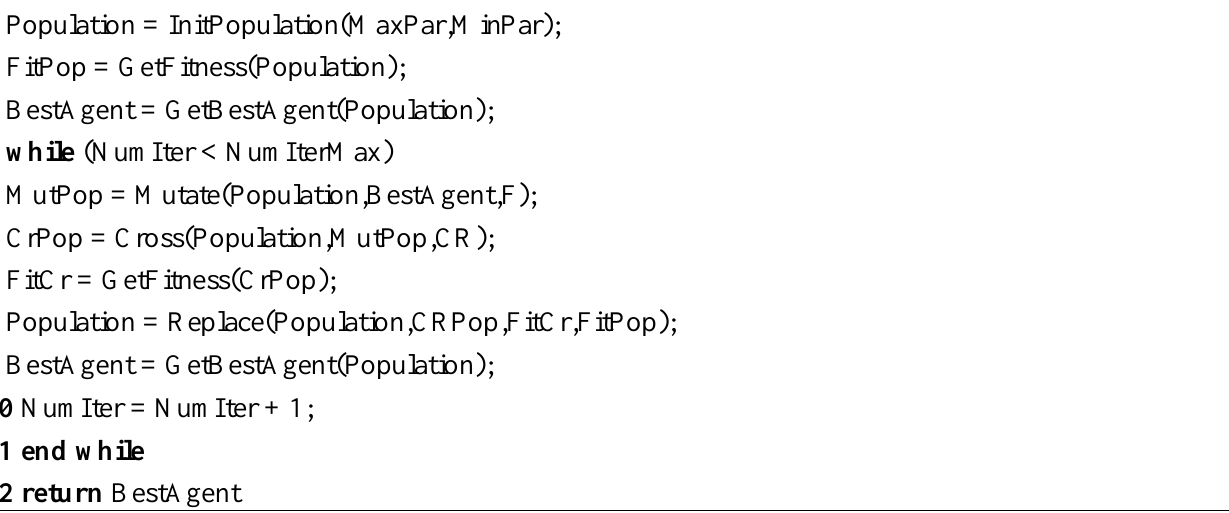
Algorithm 1. Differential evolution (DE) pseudocode